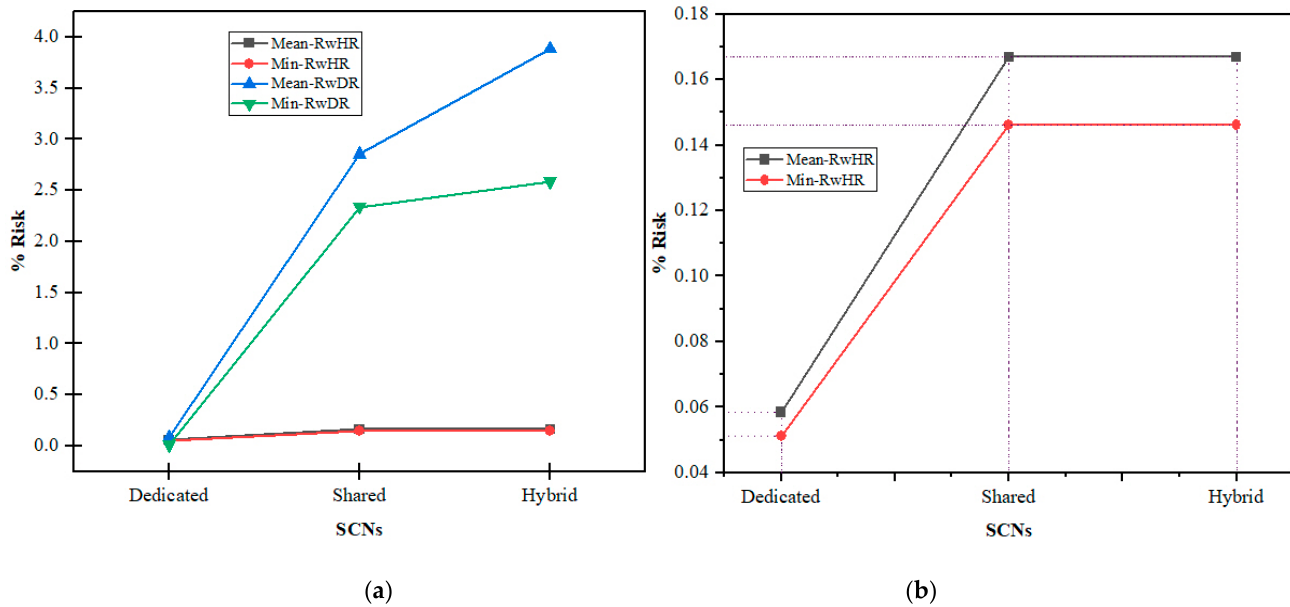
Figure 11. Comparison of risk with hardware and data reliability for different SCNs: ( a ) overall comparison, ( b ) magnified portion depicting risk with hardware reliability for different SCNs.